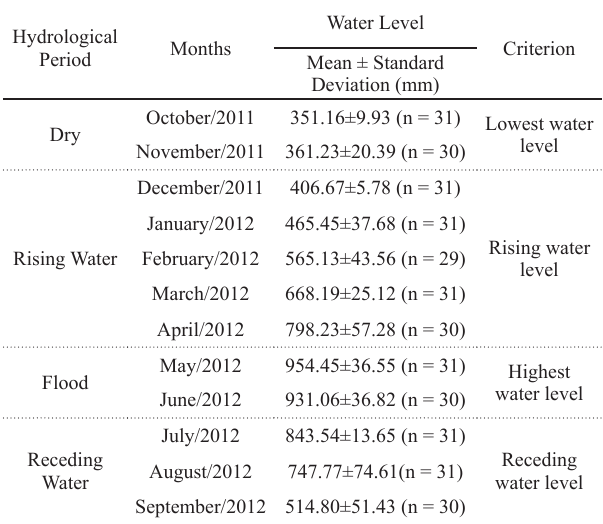
Table 1. Classification of hydrological periods according to the water level of the middle rio